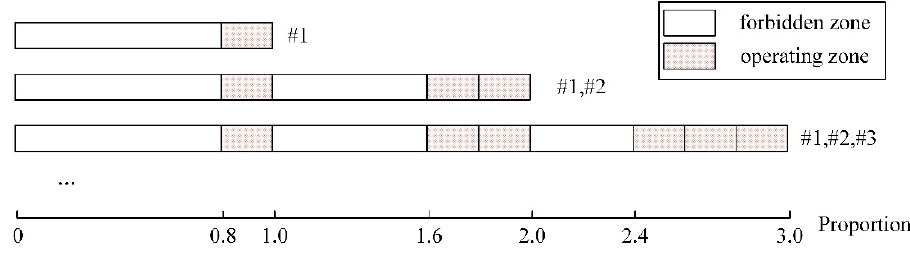
Figure 2. Model development pipeline.